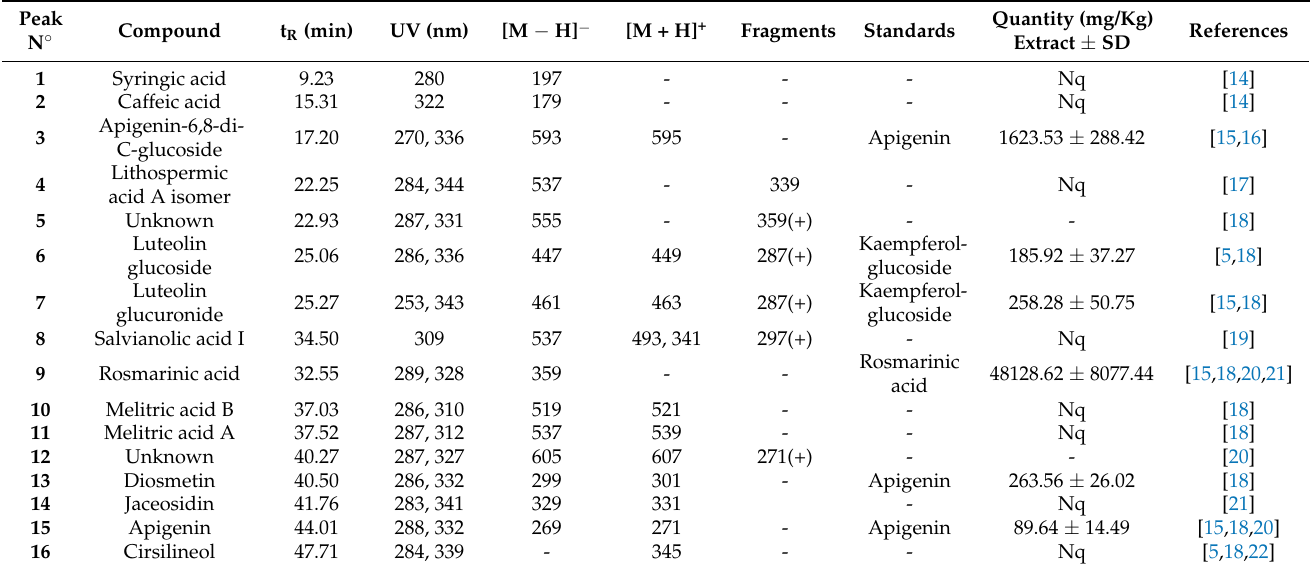
Table 2. Tentative characterization of phenolic compounds in (EtOH:H 2 O 7:3 v / v ) extract of Origanum compactum by